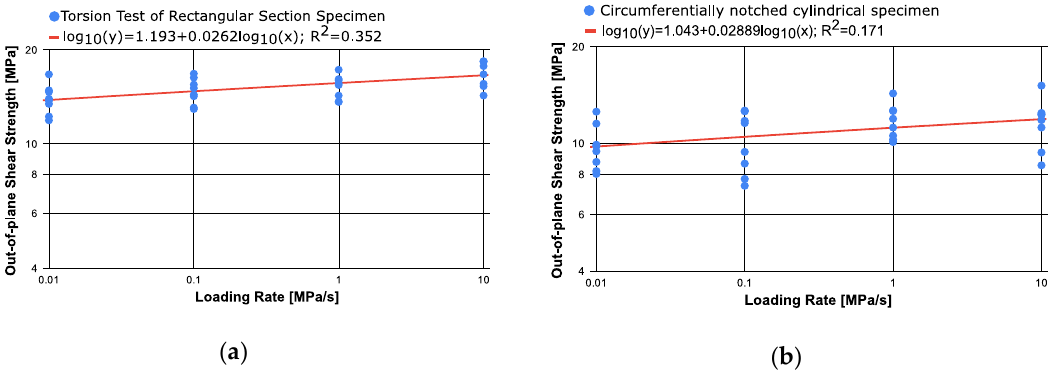
Figure 14. Out-of-plane shear strength versus loading rate: ( a ) torsion test of rectangular section specimens; ( b ) circumferentially notched cylindrical specimen test.